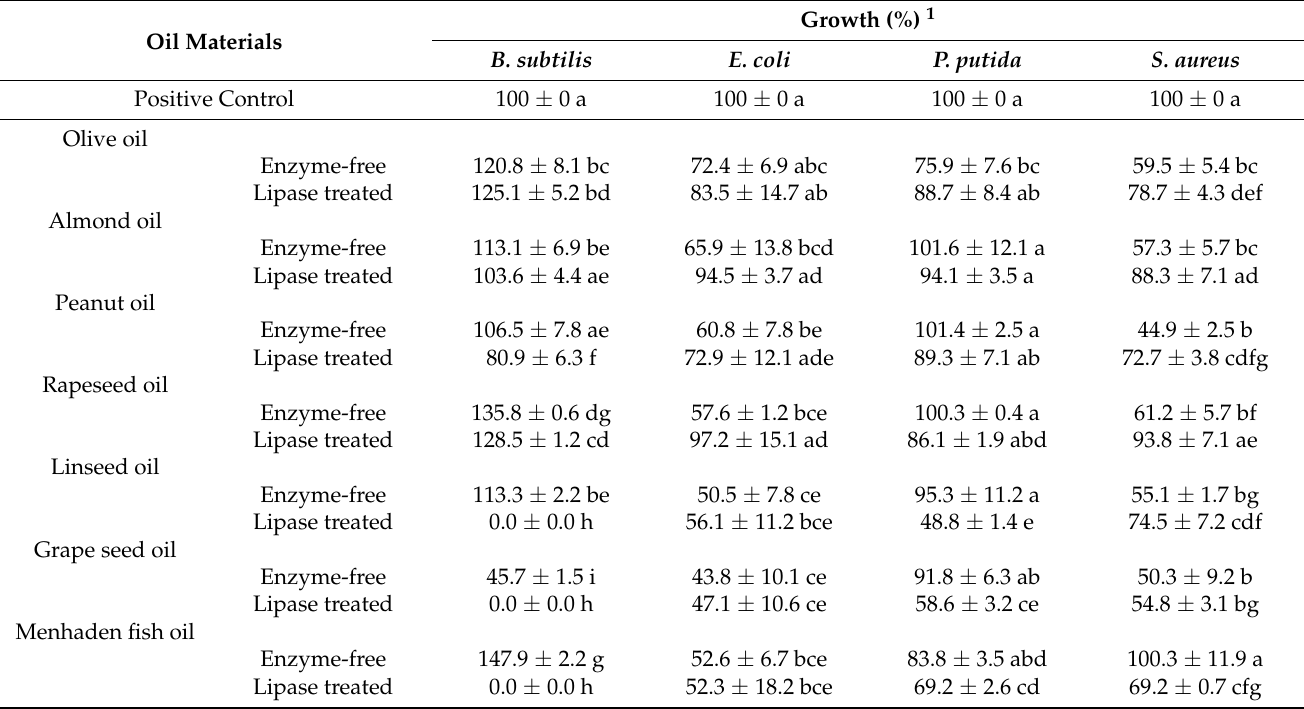
Table 3. Effects of the olive, almond, peanut, rapeseed, linseed, grape seed and menhaden fish oil samples (1.25 mg/mL lipid concentration) on growth of food-contaminating bacteria before and after treatment with R. miehei lipase. Growth in lipid-free environment containing 3.125% ( v/v ) DMSO was taken as 100% (positive